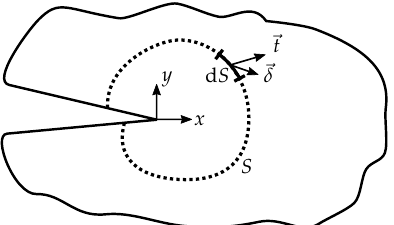
Figure 1. Schematic representation of the line J -integral around a notch for a plane